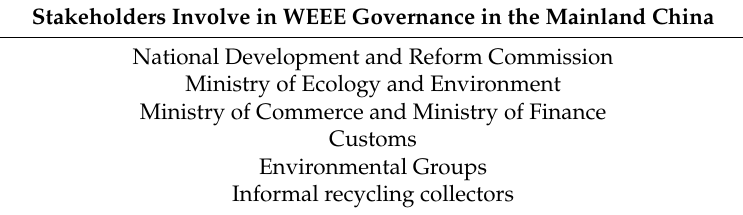
Table 3. Stakeholders involve in WEEE governance in Mainland